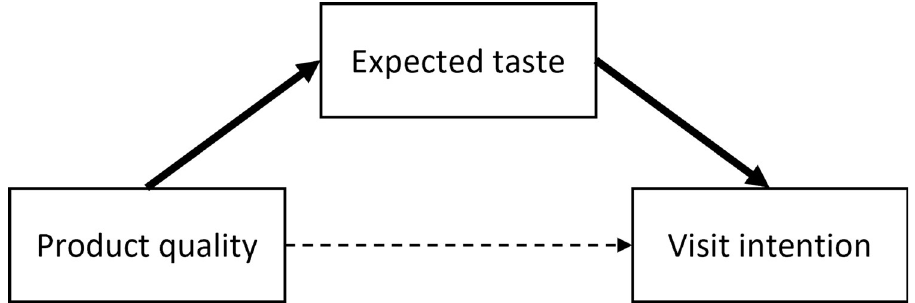
Fig 10. Relationships among evaluations of product quality, expected taste, and visit intentions. Although the direct effect of the attitudes toward quality on visit intentions is weak, the indirect effect (through taste expectations) consistently enhances consumer intentions to visit